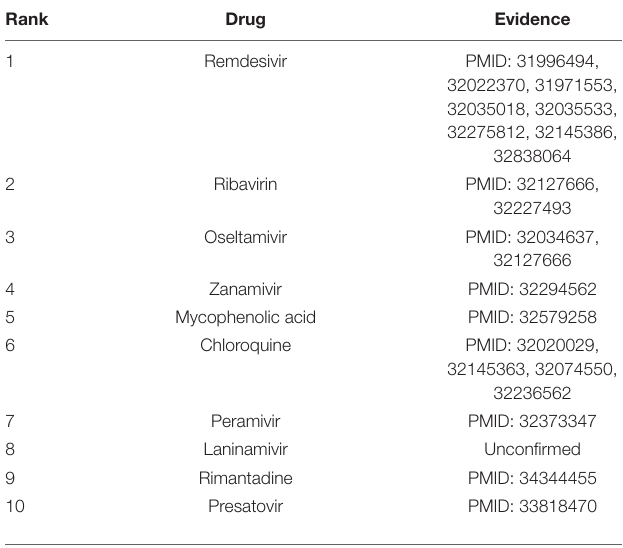
TABLE 8 | The predicted top 10 drugs associated with SARS-CoV-2 on dataset 2.